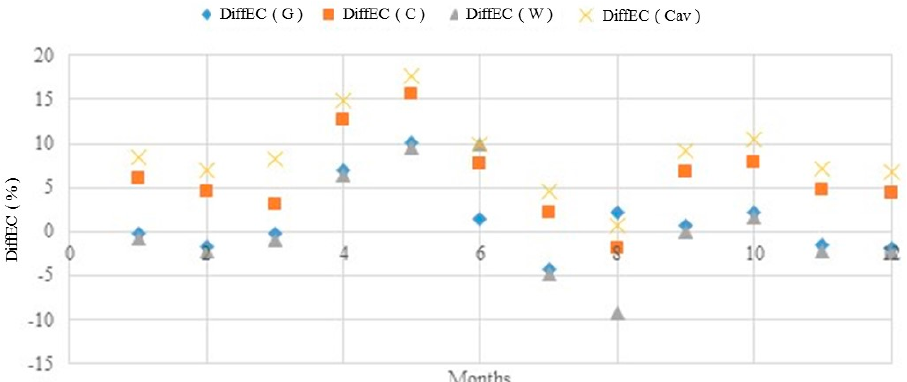
Figure 6 . Difference between measured and estimated conductivity as a percentage [ DiffEC(%) ] for Slagnäs Station in Skellefte älv for 2010. DiffEC( G ) is the difference when using the continental averages; DiffEC( C ) and DiffEC( Cav ) are the differences when using a single sample and a one-year average to calibrate the model in the customized method, respectively; and DiffEC( W ) is the difference when using the world averages.